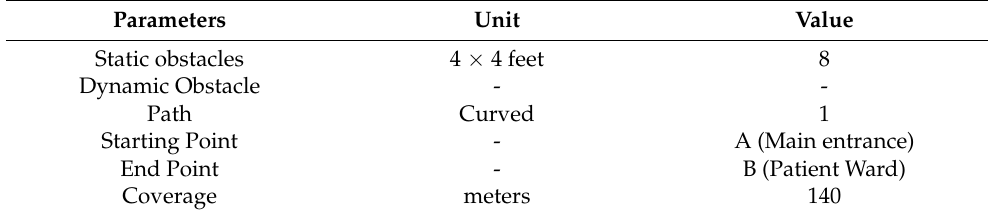
Table 3. Experimental significant